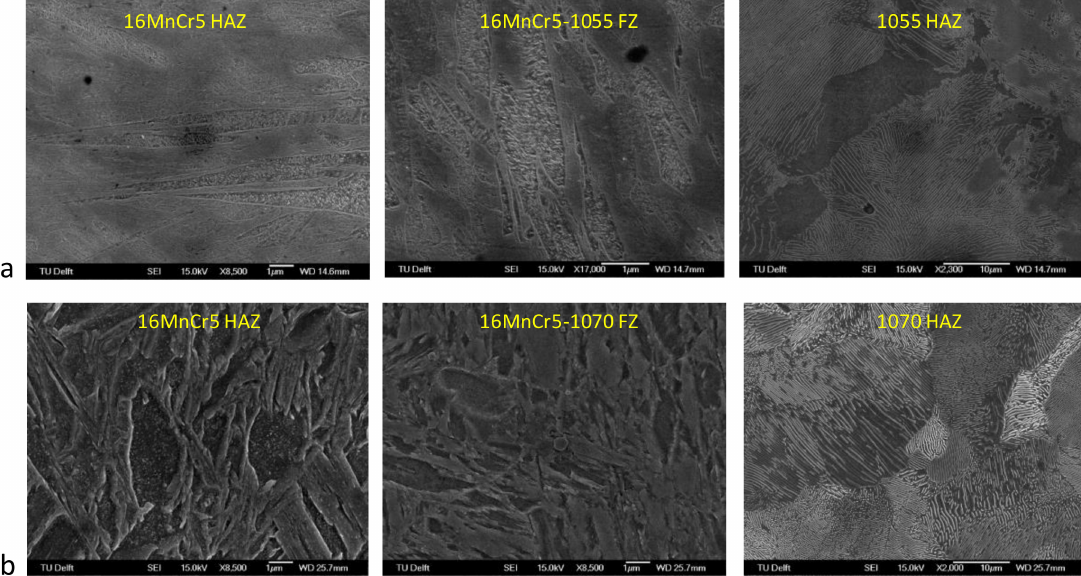
Figure 6. SEM micrographs within the HAZ and centerline of the welded regions for the following material combinations: ( a ) 16MnCr5-1055 and ( b )